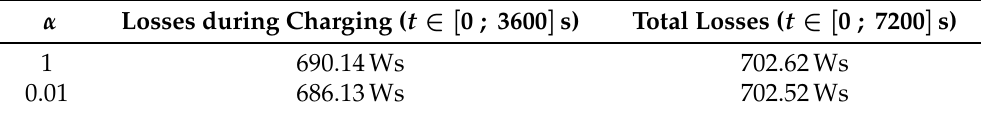
Table 3. Ohmic losses (energy) during charging and relaxation phases for partially fixed terminal states with β =